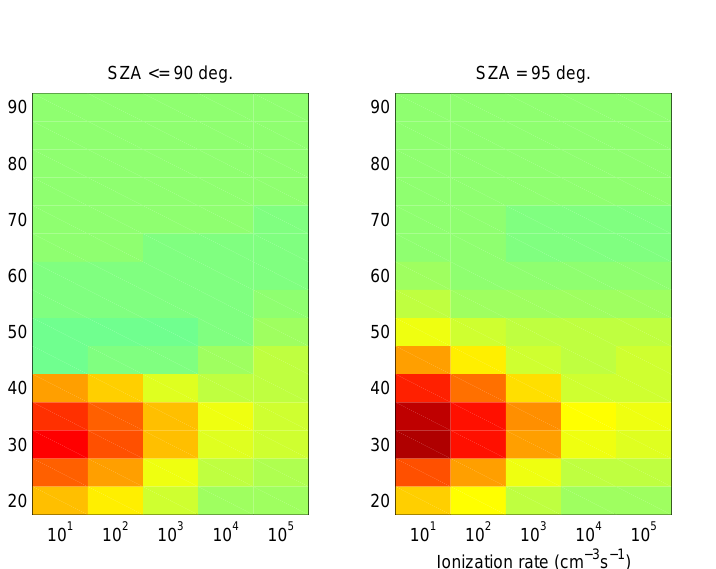
/Q for October 3